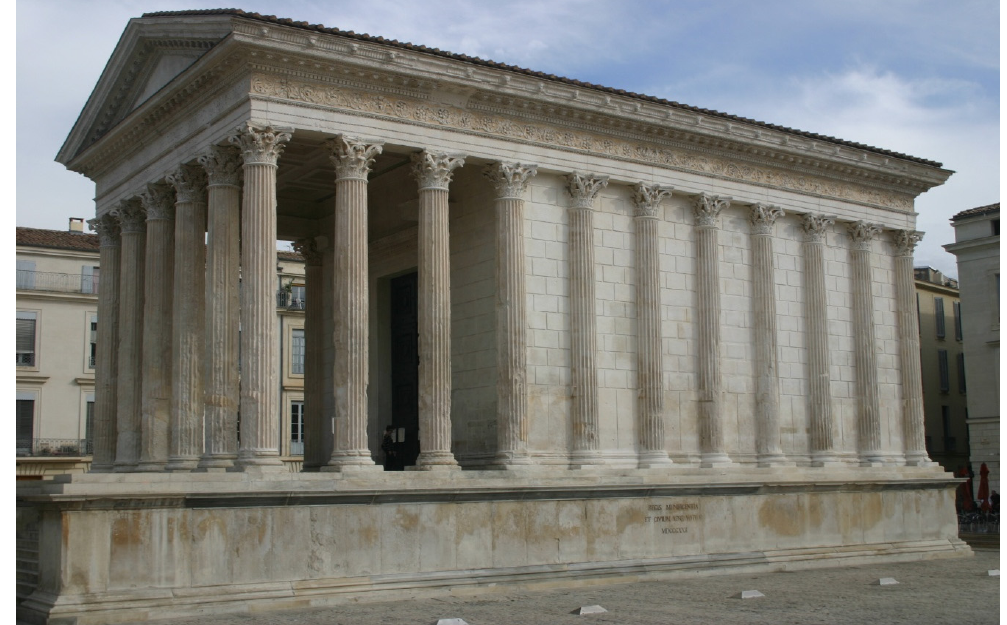
Figure 11. The Maison Carré Roman Temple in central Nîmes.